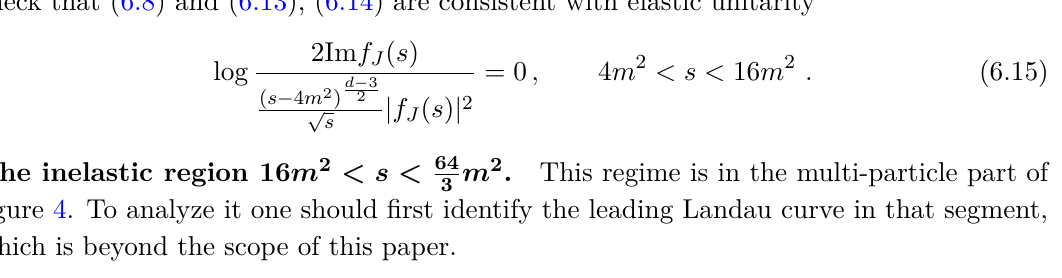
figure 4. To analyze it one should first identify the leading Landau curve in that segment, which is beyond the scope of this